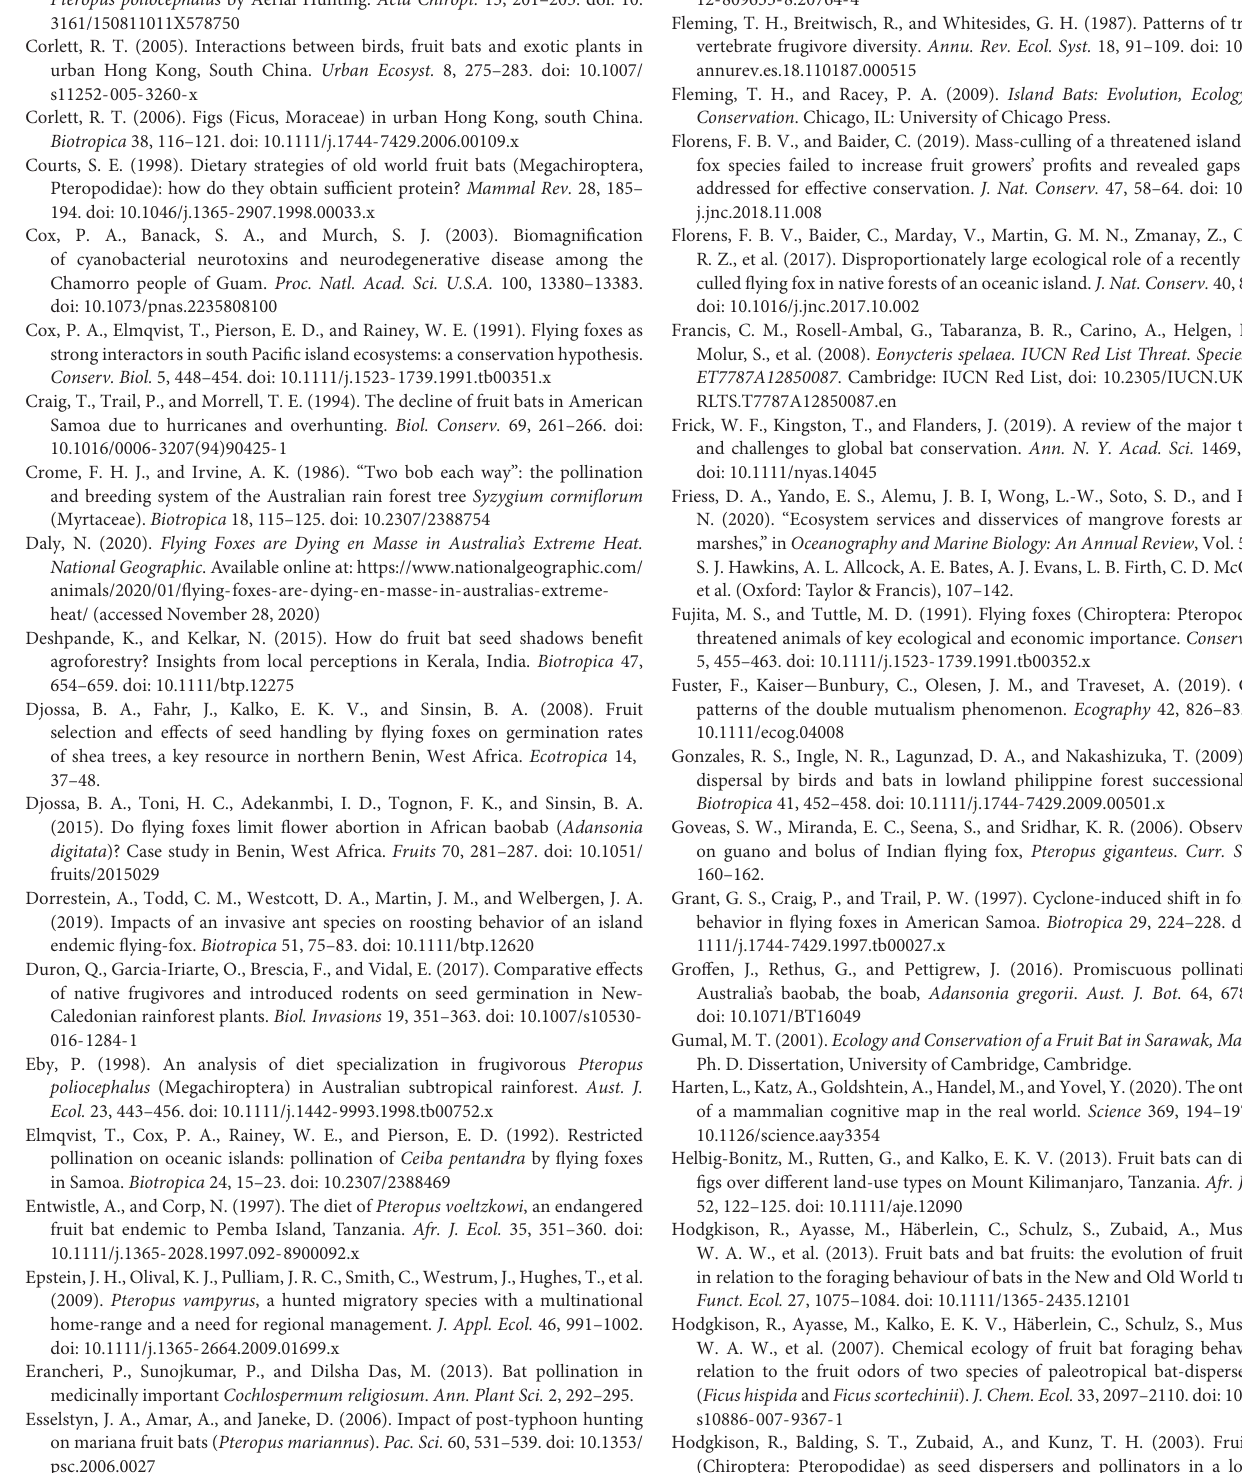
(Chiroptera: Pteropodidae) as seed dispersers and pollinators in a lowland